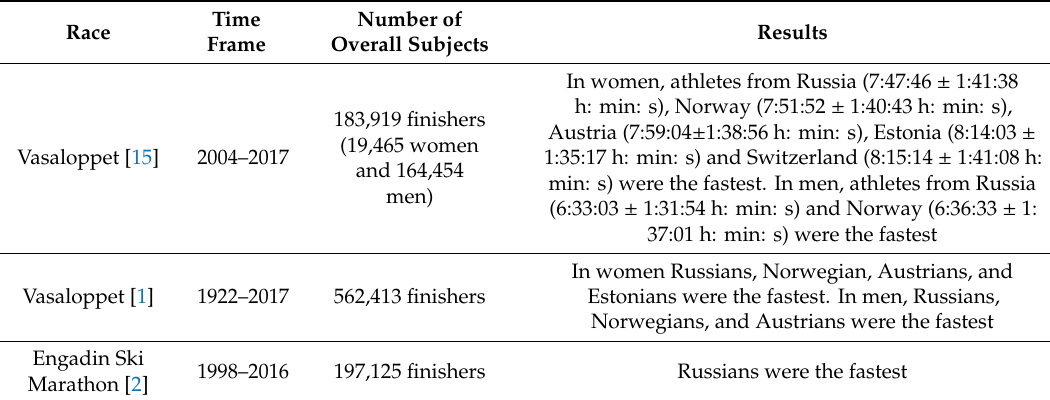
Table 1. Cross-country skiing races with dominance of Russian